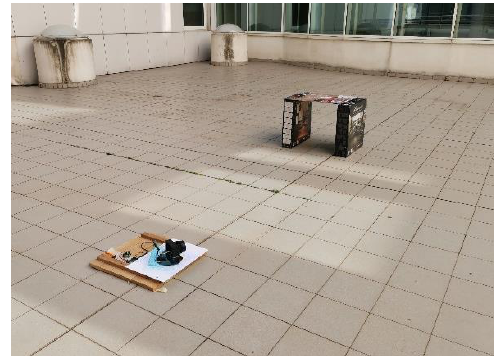
Figure 20. Sample points relative to the two obstacles.